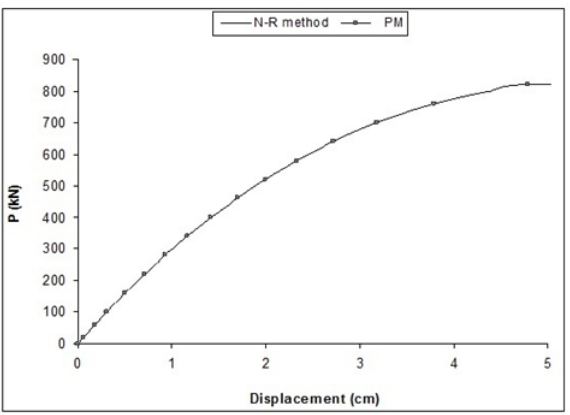
Figure 9. Space truss with 168 – members, all dimensions are in mm.